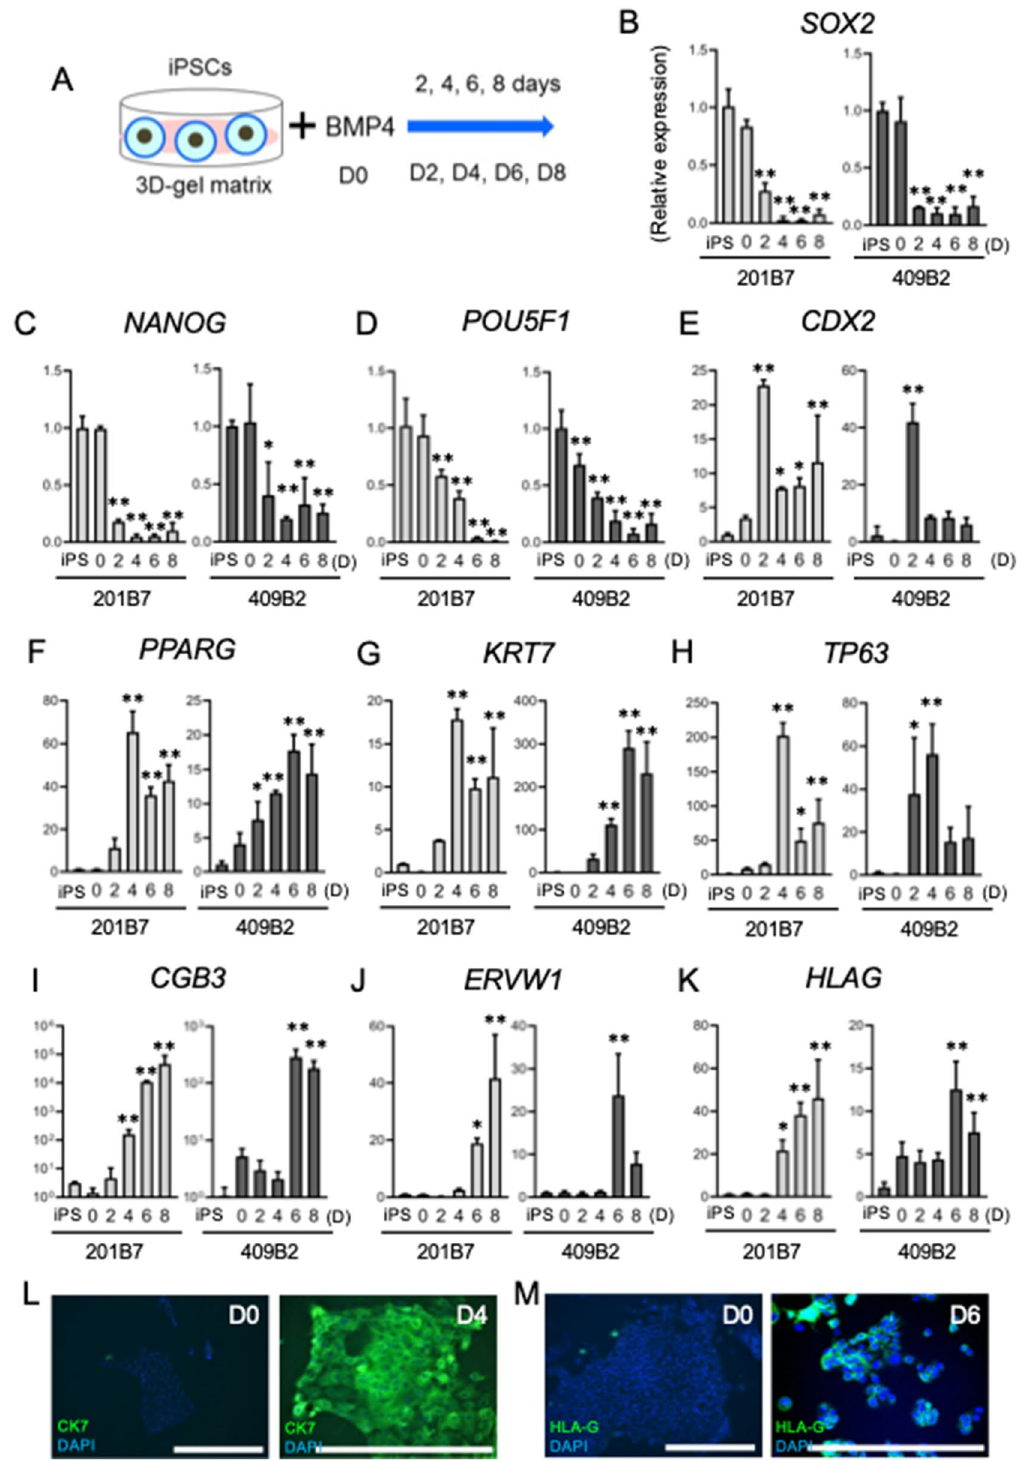
Figure 1. Trophoblastic differentiation of iPSCs by means of BMP4 treatment. ( A ) Our scheme for inducing trophoblast-like cells from iPSCs. iPSCs were treated with BMP4 for 2, 4, 6, and 8 days (D2, D4, D6, and D8, respectively). ( B – K ) mRNA expression of trophoblast markers in BMP4-treated iPSCs (201B7 and 409B2) from day 0 (D0) to day 8 (D8) of culture. Relative mRNA expression level of each gene was compared to the level of iPSCs, and statistical significance was analyzed by ANOVA. Error bars represent SD. n = 3 in each group. * P < 0.05, ** P < 0.01. (L) Immunofluorescence of CK7 (green, upper panel) and HLAG (green, lower panel) in BMP4-treated iPSCs (201B7) at day 0, 4, and 6 (D0, D4, and D6, respectively). Nucleus was stained by DAPI (blue). Bars, 300